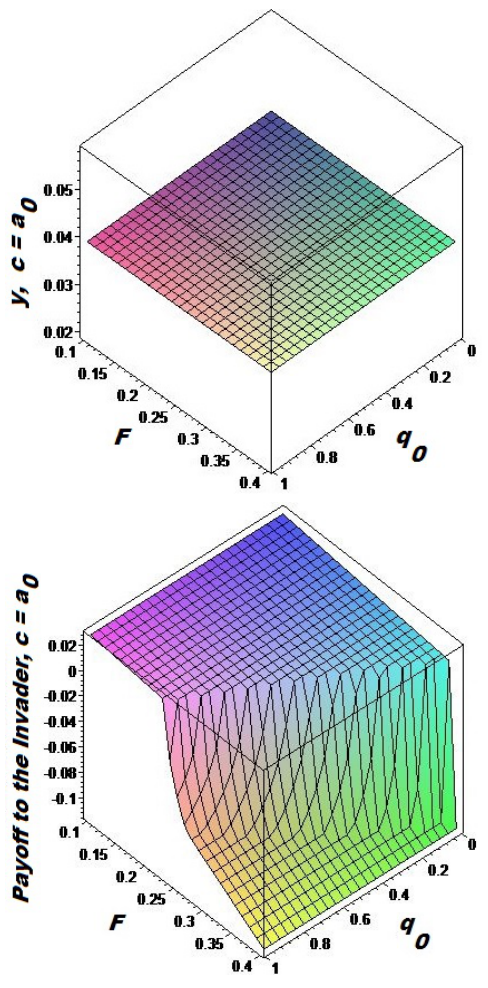
Figure 2. Equilibrium strategy y (upper) and payoff (bottom) to the Invader for c = a . 0